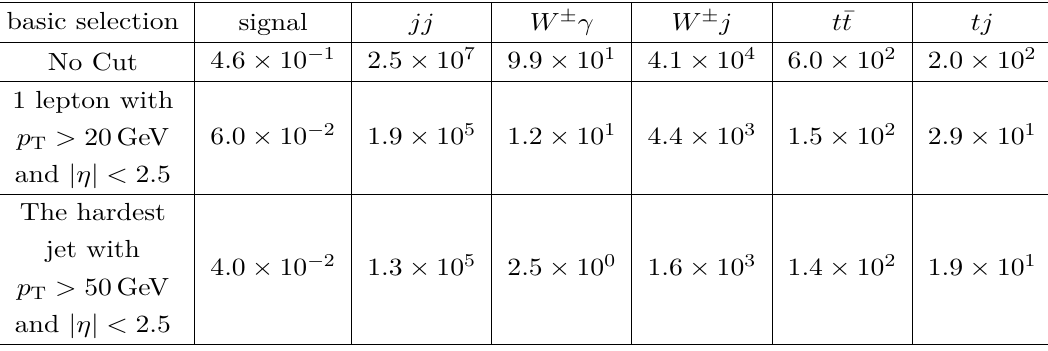
Table 2 . The basic selection cut-flow of the cross sections (in units of pb) for the ALP-strahlung production process pp → W ± a with m =3 GeV at the 14 TeV LHC where g are set to 0.64 TeV − 1 . a aγγ As a comparison, the corresponding results of the backgrounds are also listed.